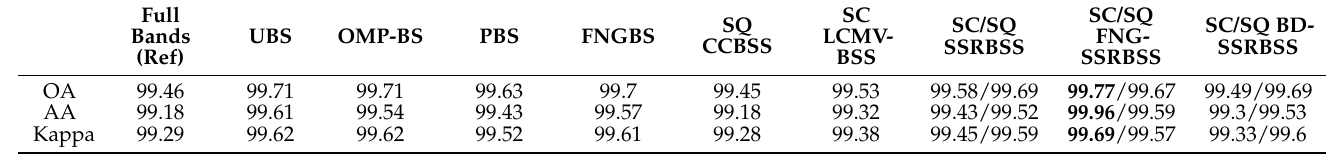
Table 9. HybridSN classification results of using the bands described in Table 3 for the Pavia